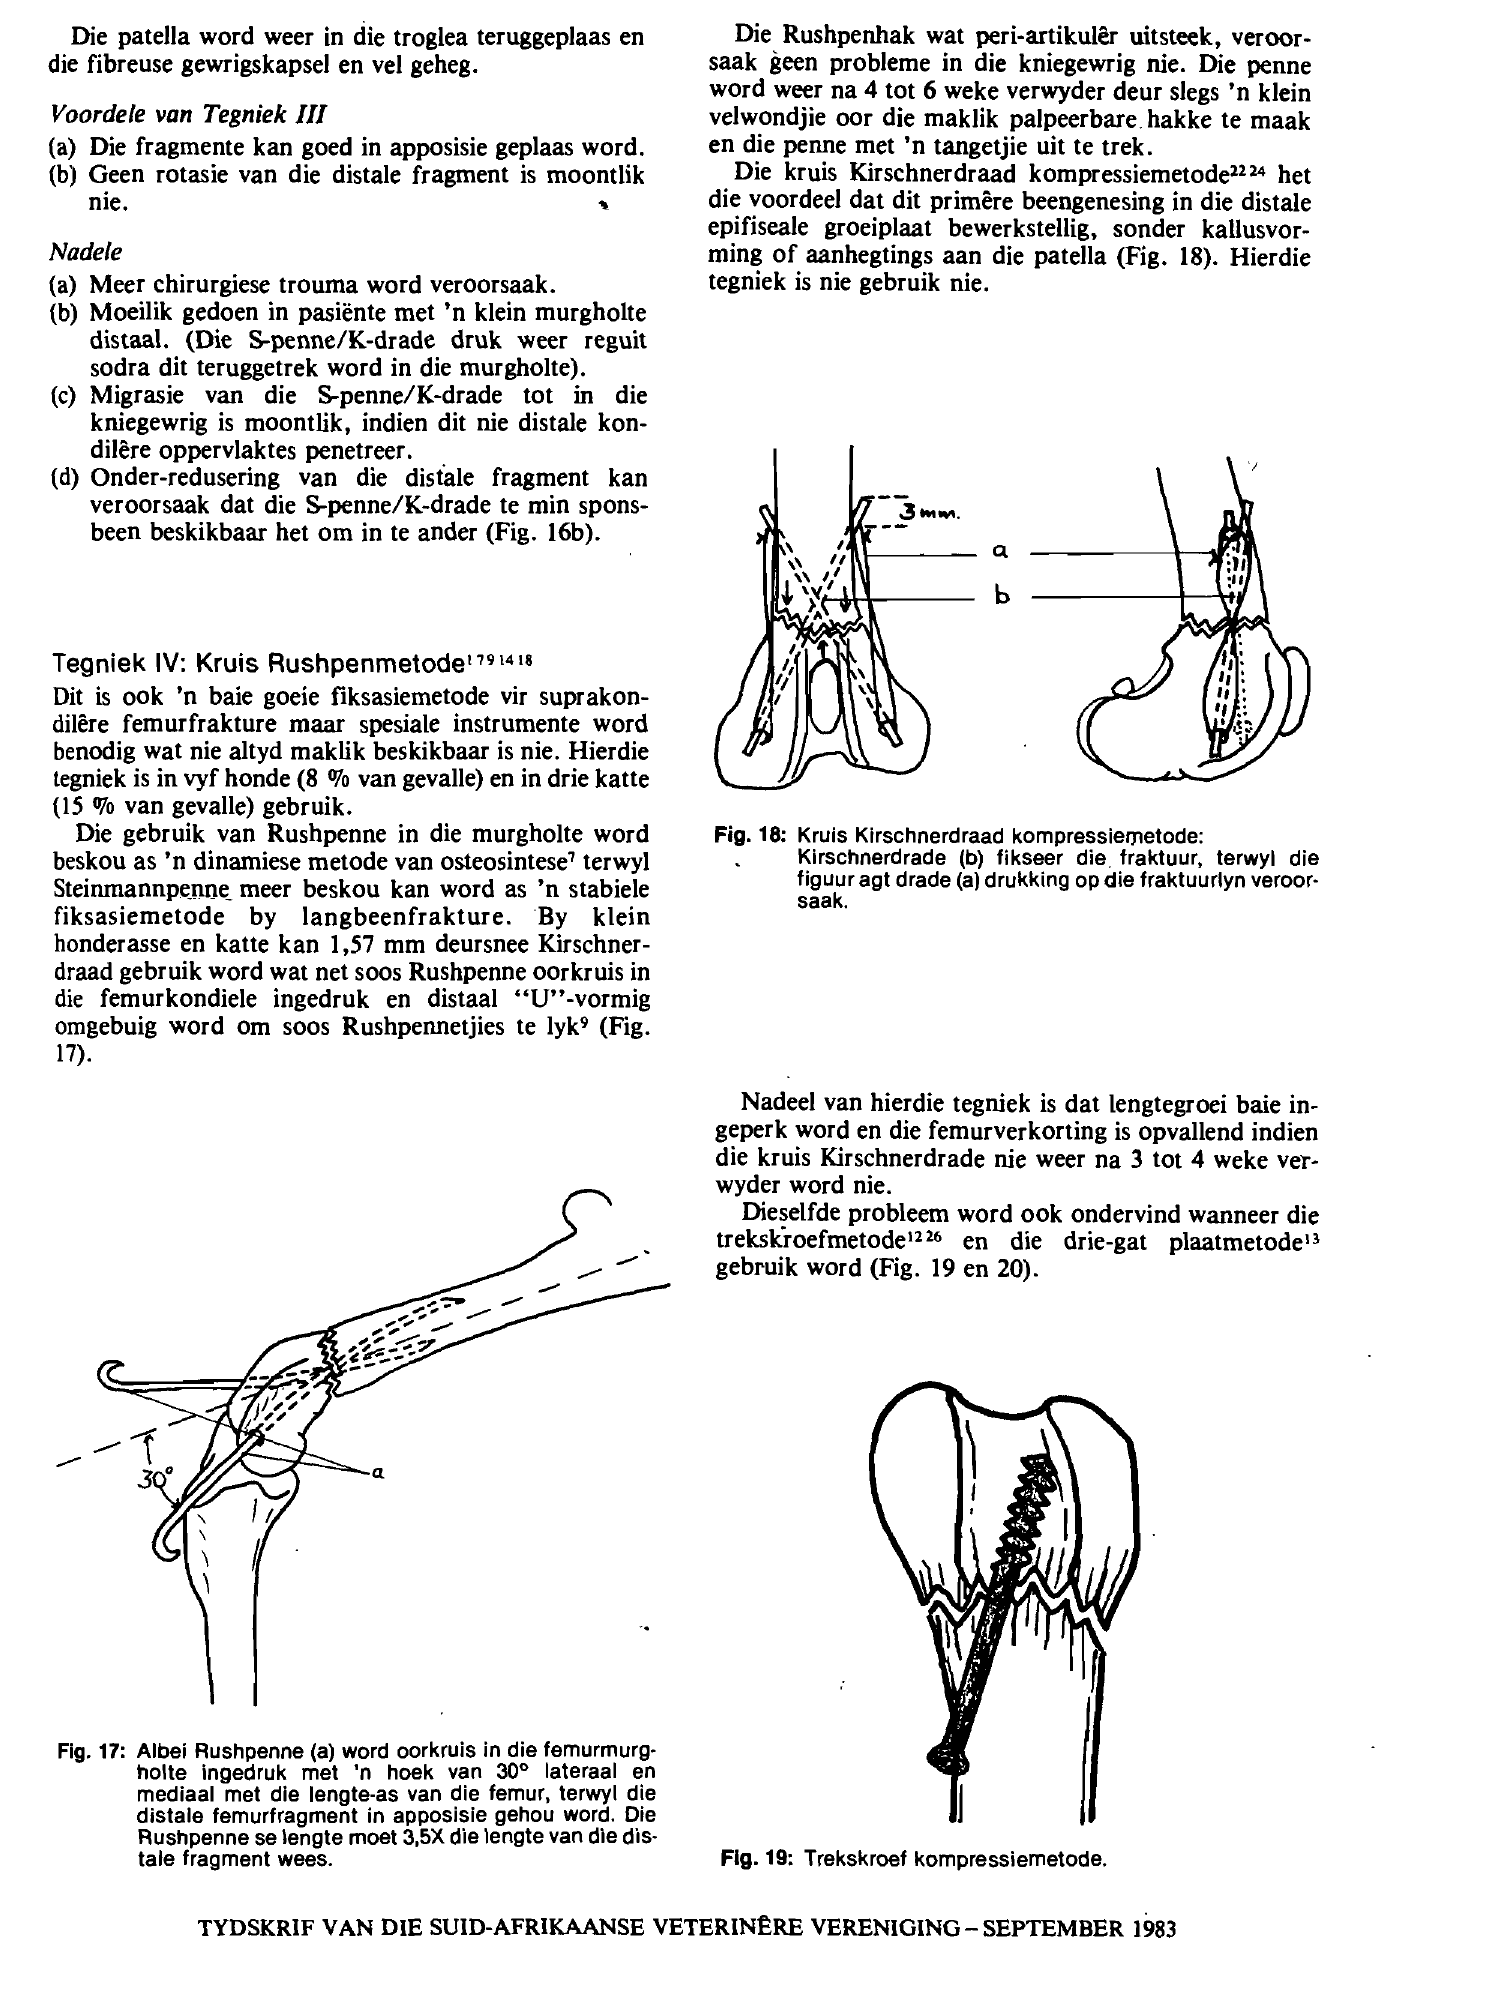
Fig. 19: Trekskroef